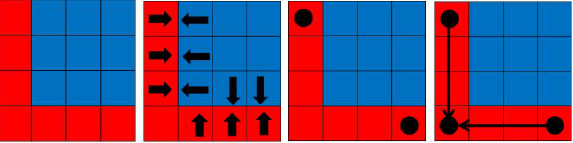
Figure 3: The Diagram of the Procedure of Edge